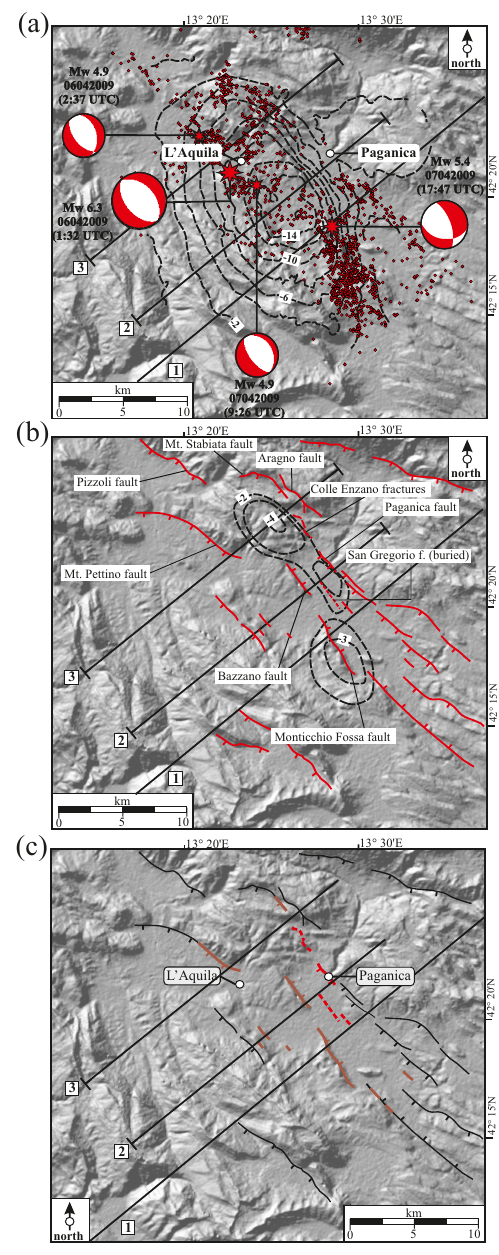
Figure 2. (a) Map view of the L’Aquila area showing the loca- tion (red stars) and focal mechanisms of the largest events of the 2009 sequence (Scognamiglio et al., 2010). Dashed lines are con- tours of elevation changes observed between 4 and 12 April 2009 (D’Agostino et al., 2012). Red dots indicate relocated aftershocks (Chiaraluce et al., 2011). (b) Presumed active faults, shown by red lines. S1 and S2 indicate the traces of cross sections 1 and 2. Dashed lines are contours of the elevation changes observed between 12 April and 5 October 2009 (D’Agostino et al., 2012). (c) Faults re- ported as activated during the 2009 earthquake. Those shown in red are discontinuous fractures mapped close to the Paganica fault; black lines are presumed active faults and brown segments repre- sent the portion of the faults reported as partially reactivated in 2009 (Emergeo Working Group, 2010). Solid Earth, 5, 389–408,